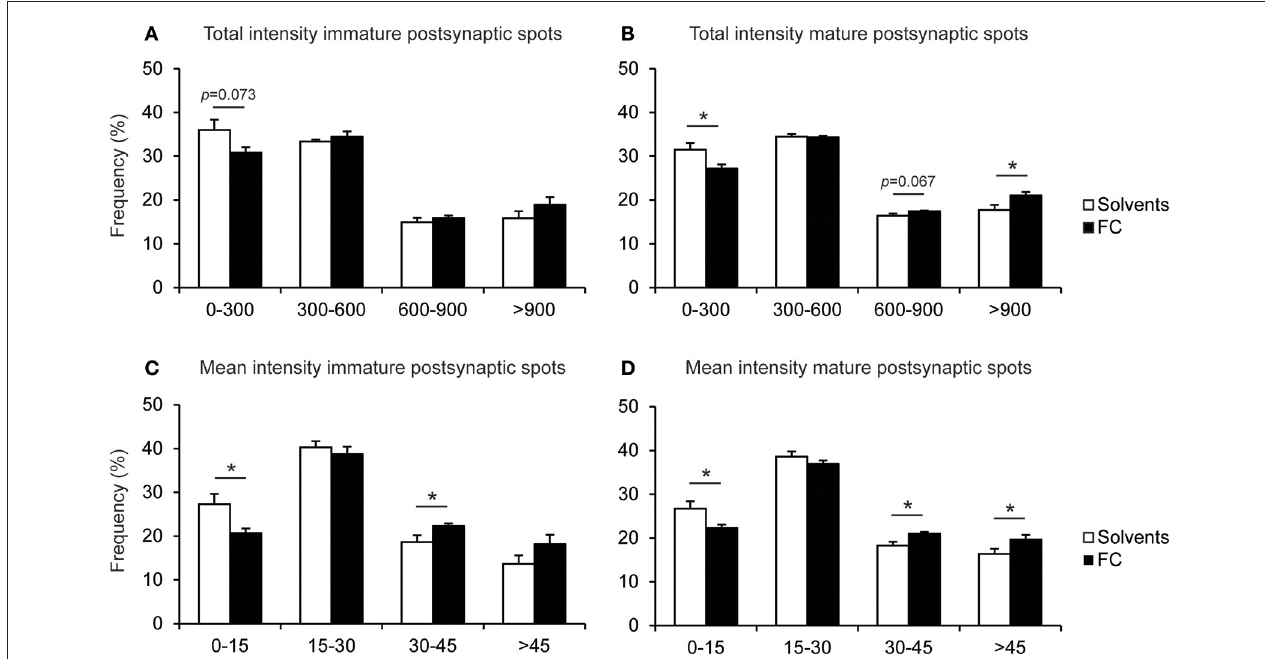
FIGURE 9 | Effect of 0.05x FC supplementation on the PSD95-intensity of immature and mature postsynaptic spots. Frequency distribution of the total PSD95 intensity of individual immature postsynaptic spots (A) and mature postsynaptic spots (B) . Frequency distribution of the mean intensity (intensity corrected for spot size) of individual immature postsynaptic spots (C) and mature postsynaptic spots (D) . Error bars represent standard error of the mean (SEM), n = 8 wells per condition, * p <